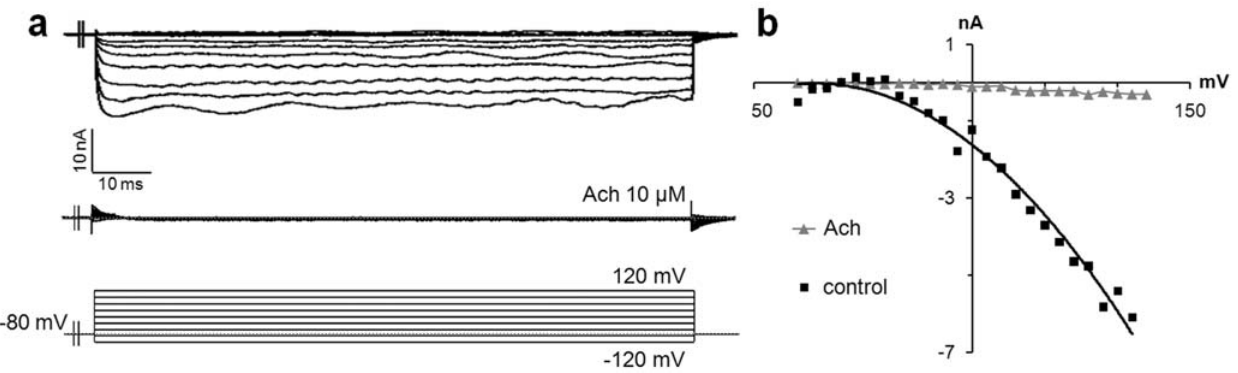
Figure 6. ACh inhibits inward currents in MCs. (a) Representative inward Ca 2 + currents without an inactivating component (top traces) recorded in the control condition from transfected MCs of rat touch dome. These currents were almost entirely inhibited after two min of exposure to ACh (10 m M) (bottom traces). (b) Steady-state current densities were plotted as a function of voltage in normal conditions (black squares) and after stimulation with ACh (grey triangles) (n=4).